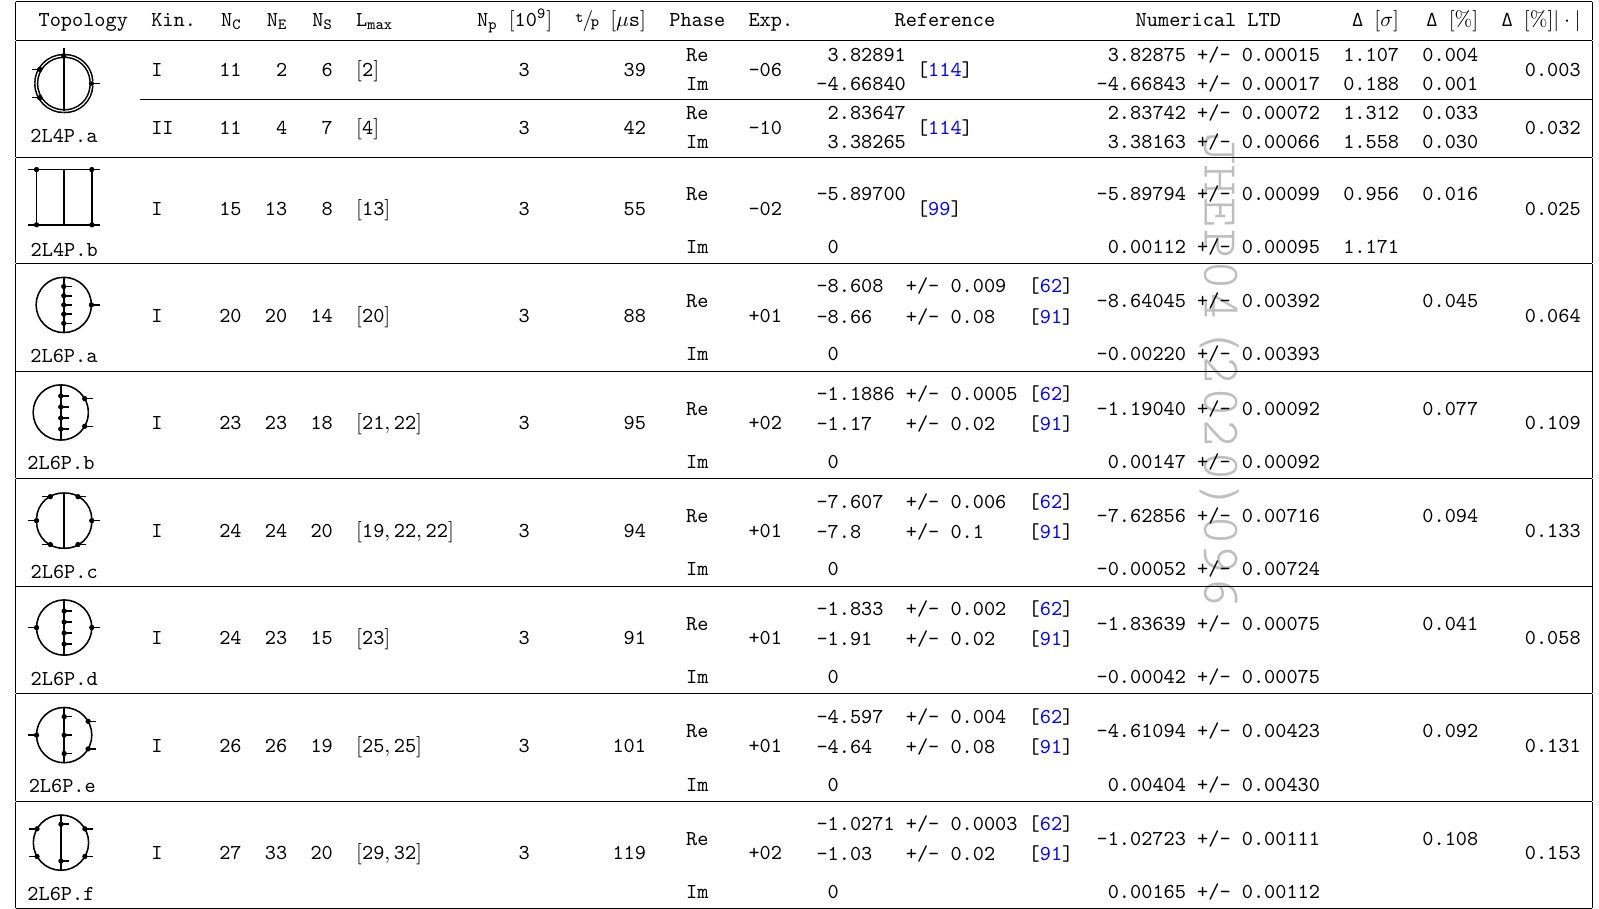
Table 2. Results for two-loop topologies with benchmark kinematics from the literature. See the main text for